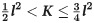
The manufacturer's profit with α in 12l2<K≤34l2.